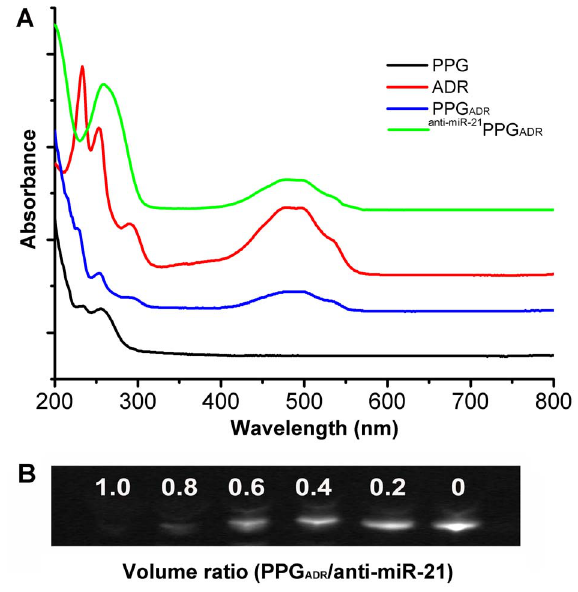
Figure 3. Fabrication of PPG ADR , anti-miR-21 PPG and anti-miR- 21 PPG ADR . (A) UV-Vis spectra of ADR, PPG, PPG ADR and in aqueous solution; (B) Electrophoretic mobility of anti-miR-21 with PPG ADR at different volume ratios.